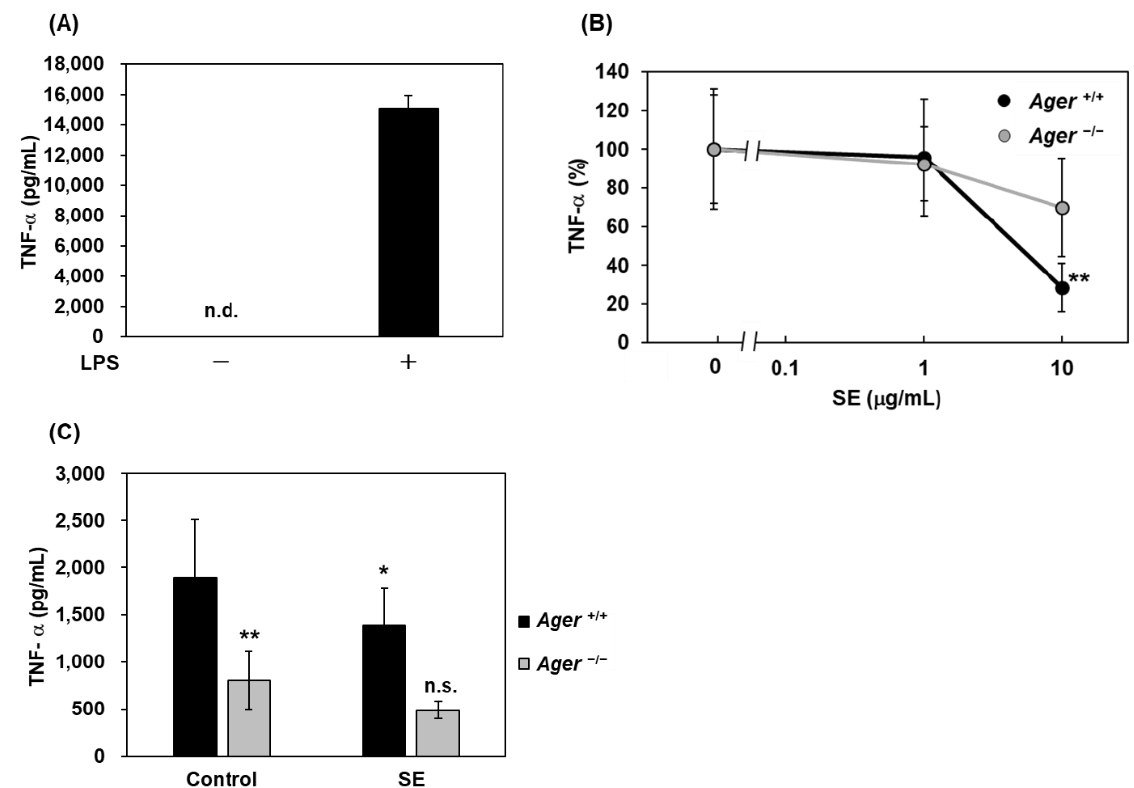
Figure 2. Inhibitory effects of SE on LPS-induced RAGE-dependent TNF-α secretion. ( A ) Mouse macrophages from Ager +/+ mice were incubated with or without LPS (50 ng/mL). TNF-α concentra- tions in cultured media were measured using ELISA. Data are expressed as mean ± SD (n = 4). n.d.; not detected. ( B ) Mouse peritoneal macrophages from Ager +/+ or Ager −/− mice were pre-incubated with SE (0, 1 or 10 μg/mL) for 1 h before stimulation with LPS (50 ng/mL) for 24 h. TNF-α concen- trations in cultured media were measured using ELISA. Data are expressed as mean ± SD (n = 3–4). **, p < 0.01 vs. LPS only (0). ( C ) TNF-α levels in the plasma of LPS-induced septic mice. Ager +/+ or Ager −/− mice were orally administered with SE (100 mg/kg) before intraperitoneal injection with LPS (1 mg/kg). Plasma TNF- concentrations were measured using ELISA. Data are expressed as mean